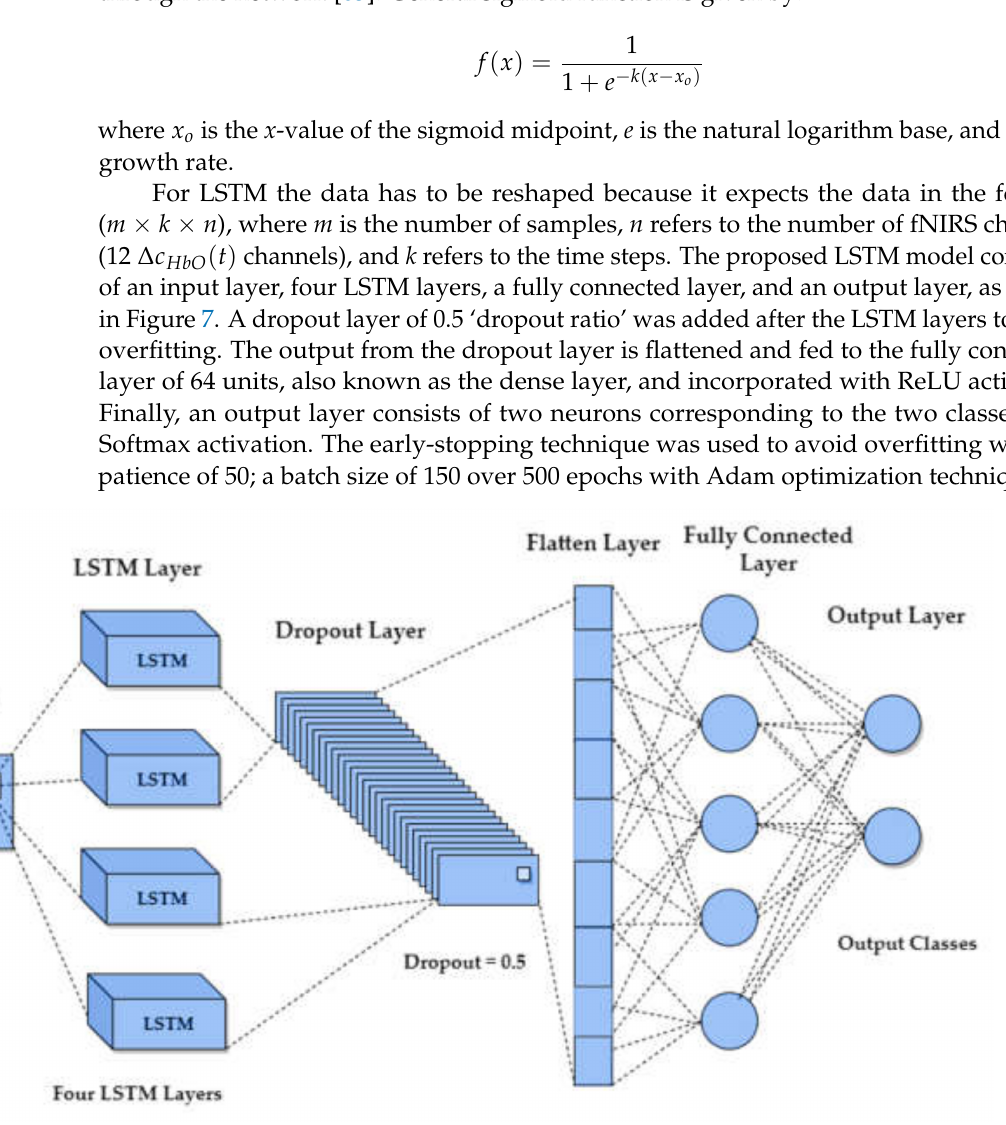
Figure 7. Long short-term memory (LSTM) model with four LSTM layers, dropout layer, flatten layer, fully connected layer, and output